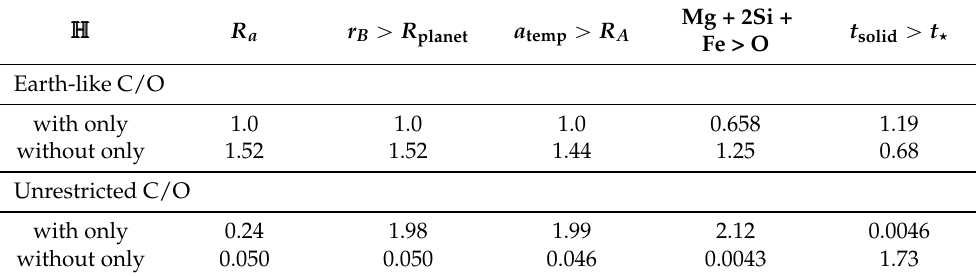
Table 2. Ablation study for planetary magnetic field criteria. This table displays the Bayes factors relative to the baseline case where planetary magnetic fields are not important. The ‘with only’ rows only incorporate the condition in the given column, and the ‘without only’ rows incorporate every condition except the condition in the given column into the probability